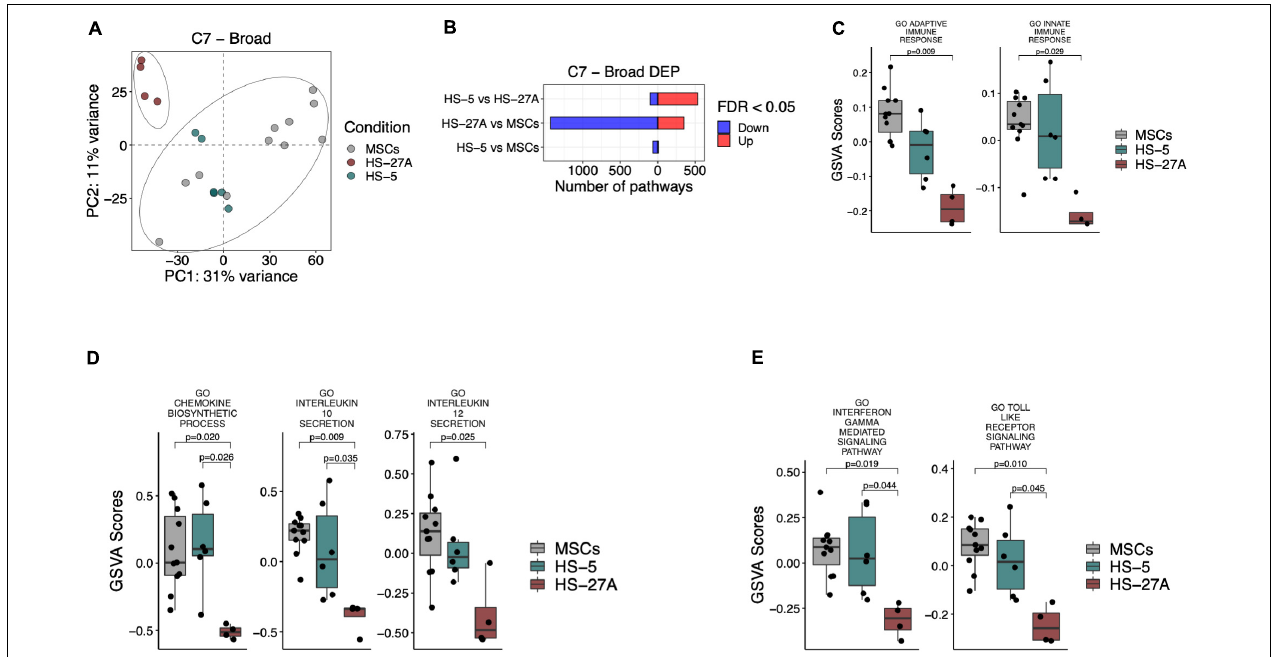
FIGURE 4 | Immunological signatures on primary MSCs, HS-5, and HS-27A cell lines. (A) Score plot of the first two PCs following the application of PCA on DEP included in C7 immunological signatures collection between primary MSCs, HS-5 and HS-27 cell lines. (B) Number of significantly down- and up-regulated pathways included in C7 immunological signatures collection between primary MSCs, HS-5 and HS-27 cell lines. (C–E) GSVA scores related to the expression of selected immunological signatures responsible for the immunoregulatory activity mediated by MSCs on primary MSCs, HS-5 and HS-27 cell lines. ( n MSCs, HS-5, HS-27A = 11, 6, 4). PCs, principal components; PCA, principal component analysis; DEP, differentially expressed pathways; GSVA, gene set variation